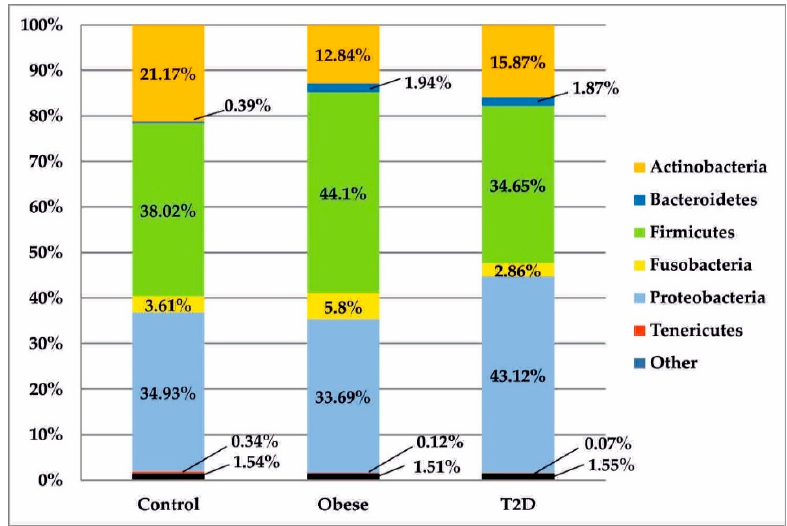
Figure 3. Bacterial profiles in the treatment and control groups at the phylum level. T2D: type 2 diabetes.